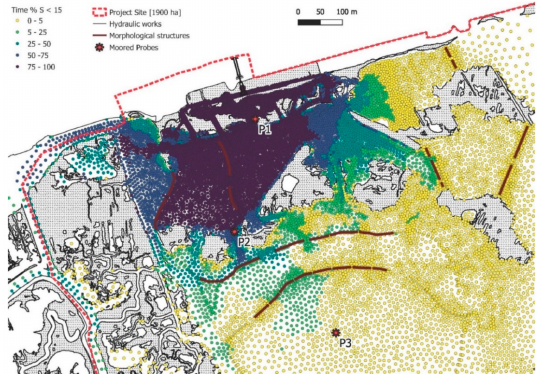
Figure 15. Maps of standard error of salinity values computed by the model within the vertical layers 11–14 in each node of the domain, for the period 23 February–10 March 2021, with a discharge of 1000 ls − 1 .